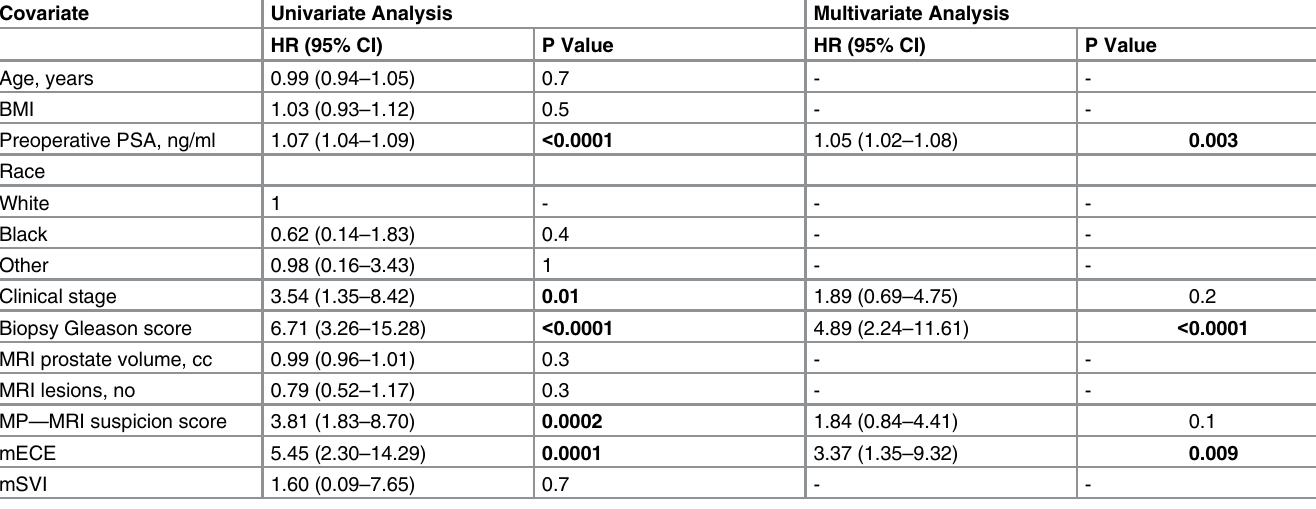
Table 4. Univariate and multivariate Cox proportional hazards regression model of clinical and imaging variables predicting biochemical recur- rence: patients with negative surgical margins. Covariate Univariate Analysis